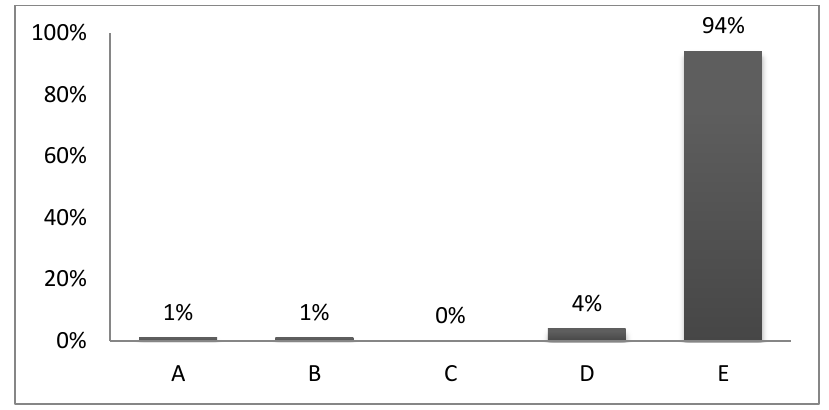
Figure 4.2: Islamic students TOEFL score